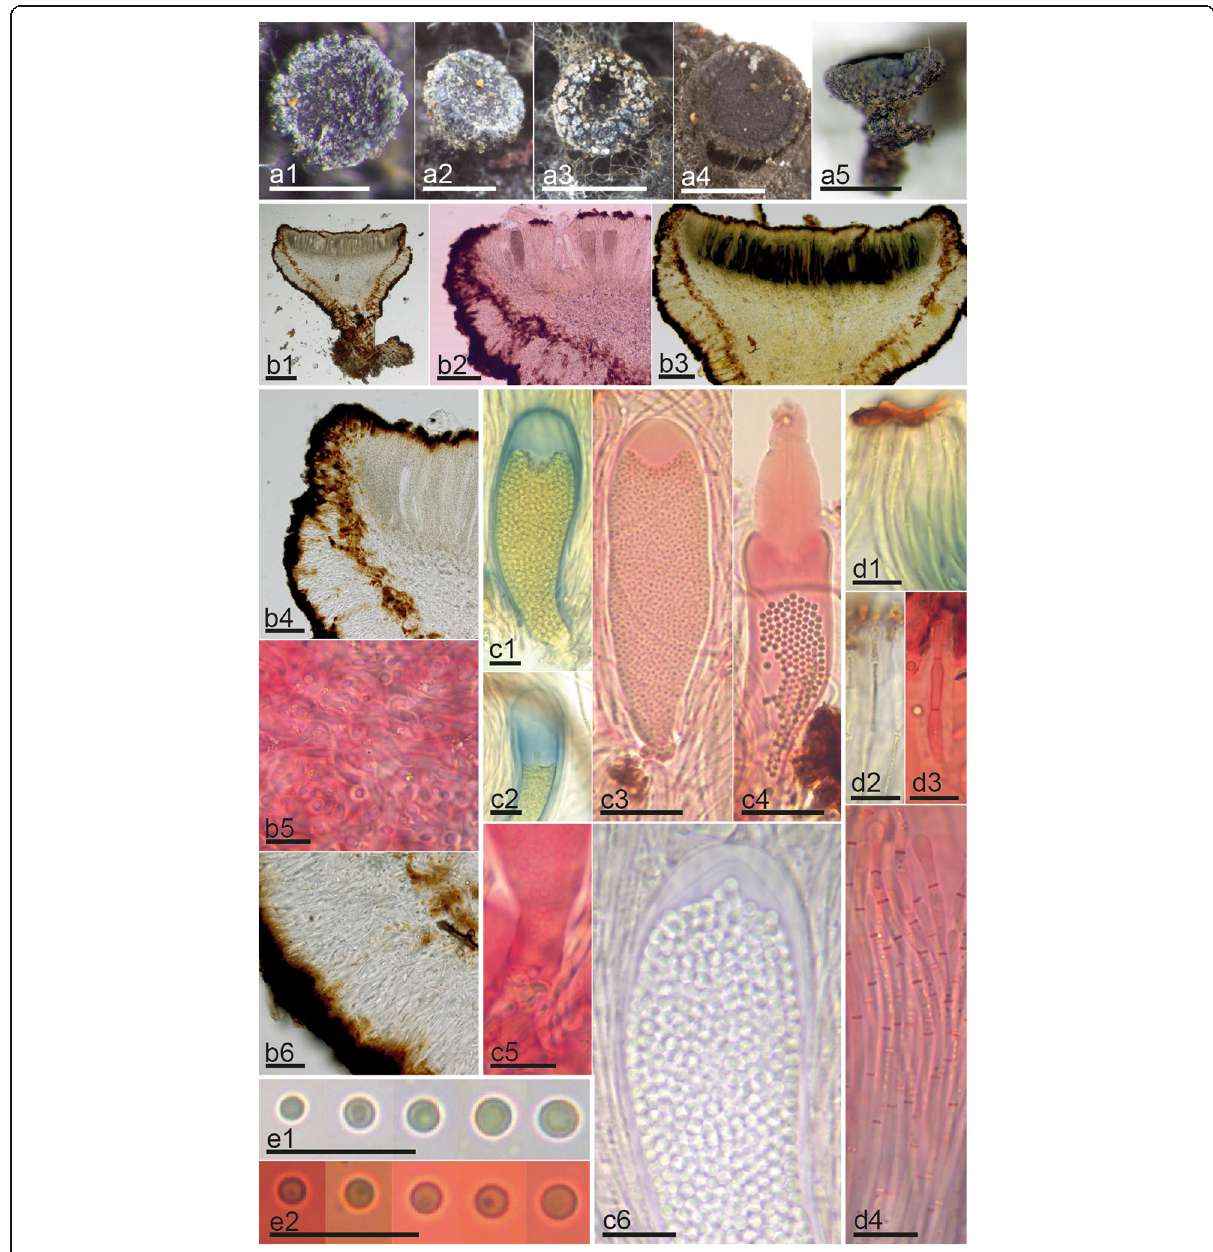
Fig. 3 Morphological features of Atrozythia klamathica . a1 – 5 Dry apothecia. b1 – 6 Median section of apothecium with details of excipulum: b4. Ectal excipulum at margin, b5. Medullary excipulum, b6. Ectal excipulum at lower flanks. c1 – 6 Morphological variation of asci: c1 – 2. Amyloid